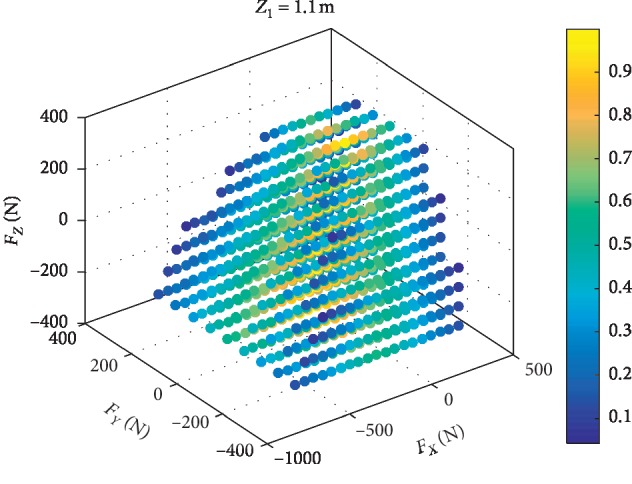
The safe range of FXYZ with Z1=1.1 m.